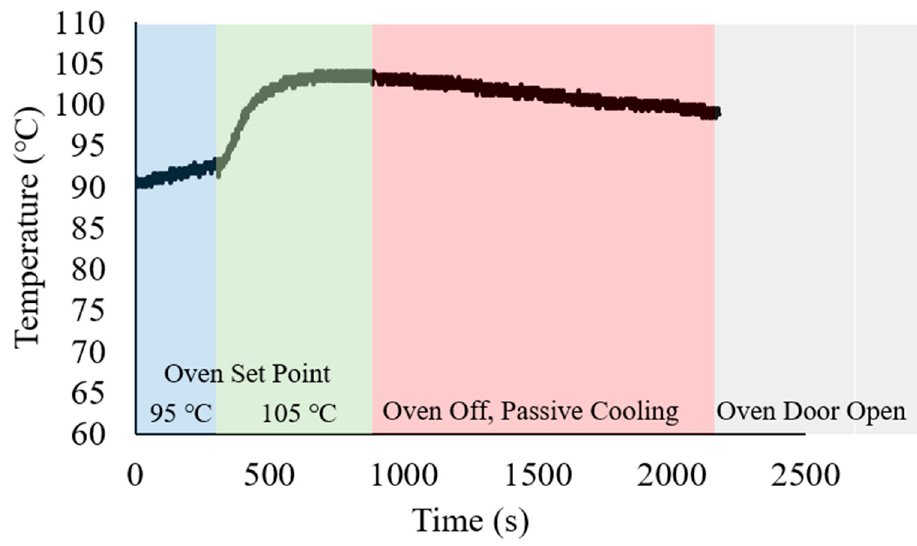
Figure 9. Data collected from the MSP430 controlled by the SMP/SMA switch. Temperature set points of the oven were